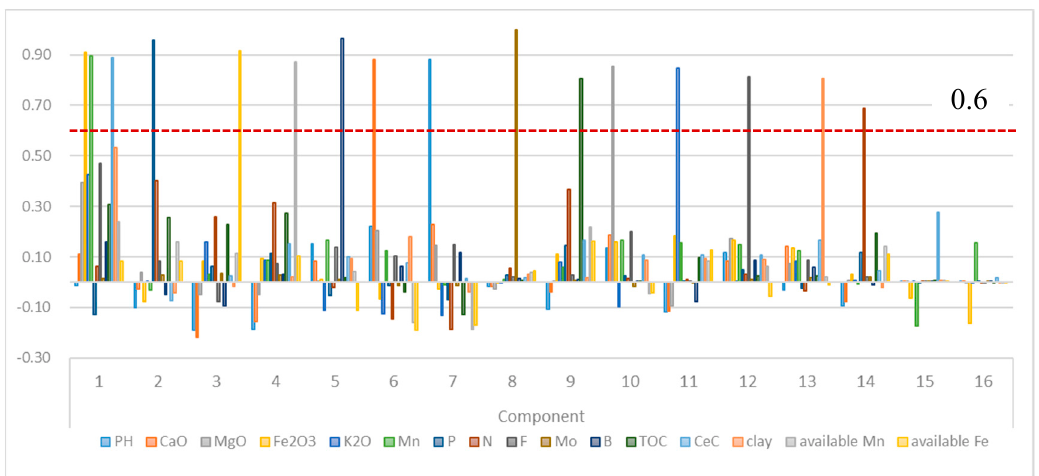
Figure 8. The factor load value of 16 components by Varimax with Kaiser normalization. (Fourteen components were extracted; the red line shows the load value > 0.6).